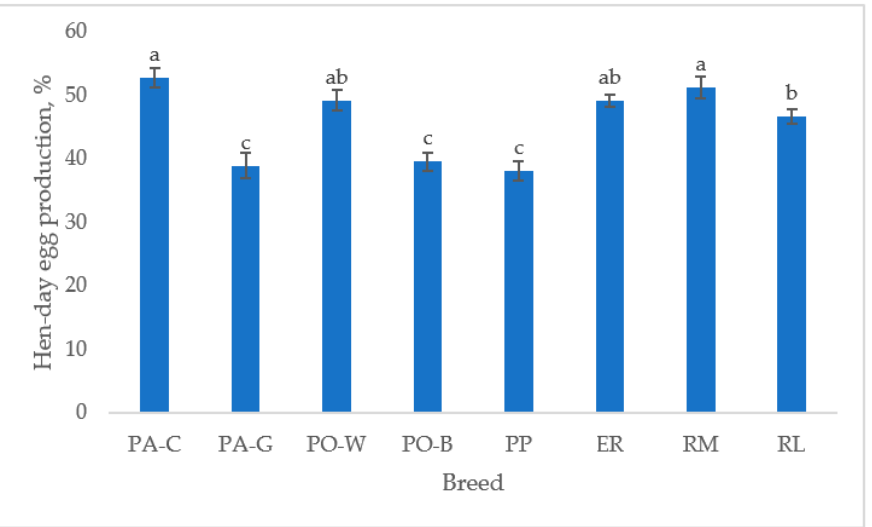
Figure 1. Least squares means (with SE) of hen-day egg production (from 39 to 50 weeks of age; observations ( n ) = 85 per breed). PA-C: Padovana Camosciata; PA-G: Padovana Dorata; PO-W: Polverara Bianca; PO-B: Polverara Nera; PP: Pepoi; ER: Ermellinata di Rovigo; RM: Robusta Maculata; RL: Robusta Lionata. Different letters indicate statistically different means (a,b,c: p < 0.05).